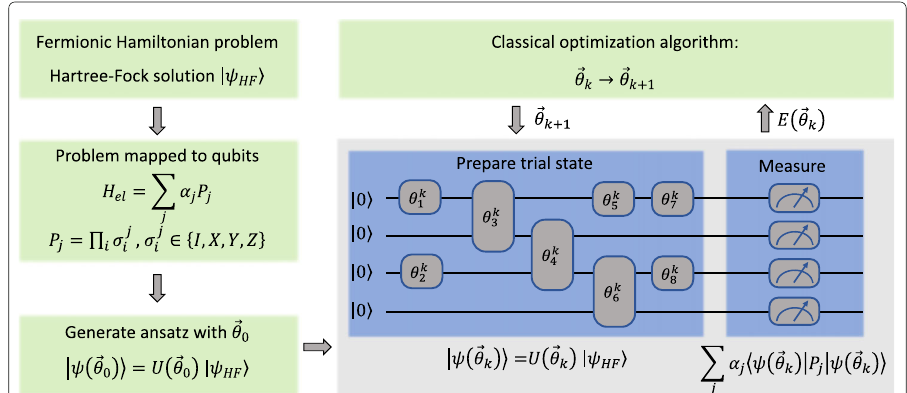
Fig. 1 Schematic of the variational quantum eigensolver (VQE) method that minimizes the energy of the Hamiltonian (cid:6) ψ( (cid:4) θ) |ˆ H el | ψ( (cid:4) θ) (cid:5) by adjusting variational parameters θ . It uses classical computing resources denoted by green color and quantum computing resources denoted by blue. A simulation starts by constructing a fermionic Hamiltonian and finding mean-field solution | ψ HF (cid:5) . Next, the fermionic Hamiltonian is mapped into qubit Hamiltonian, represented as a sum of Pauli strings H = represent the wave function is chosen and initialized with the initial set of parameters (cid:4) θ 0 . The trial state is prepared on a quantum computer as a quantum circuit consisting of parametrized gates. The rest of the procedure is performed repeatedly until the convergence criterion is met. At iteration k the energy of the Hamiltonian is computed by measuring every Hamiltonian term (cid:6) ψ( (cid:4) θ k ) | P j | ψ( (cid:4) θ k ) (cid:5) on a quantum computer and adding them on a classical computer. The energy E ( (cid:4) θ k ) is fed into the classical algorithm that